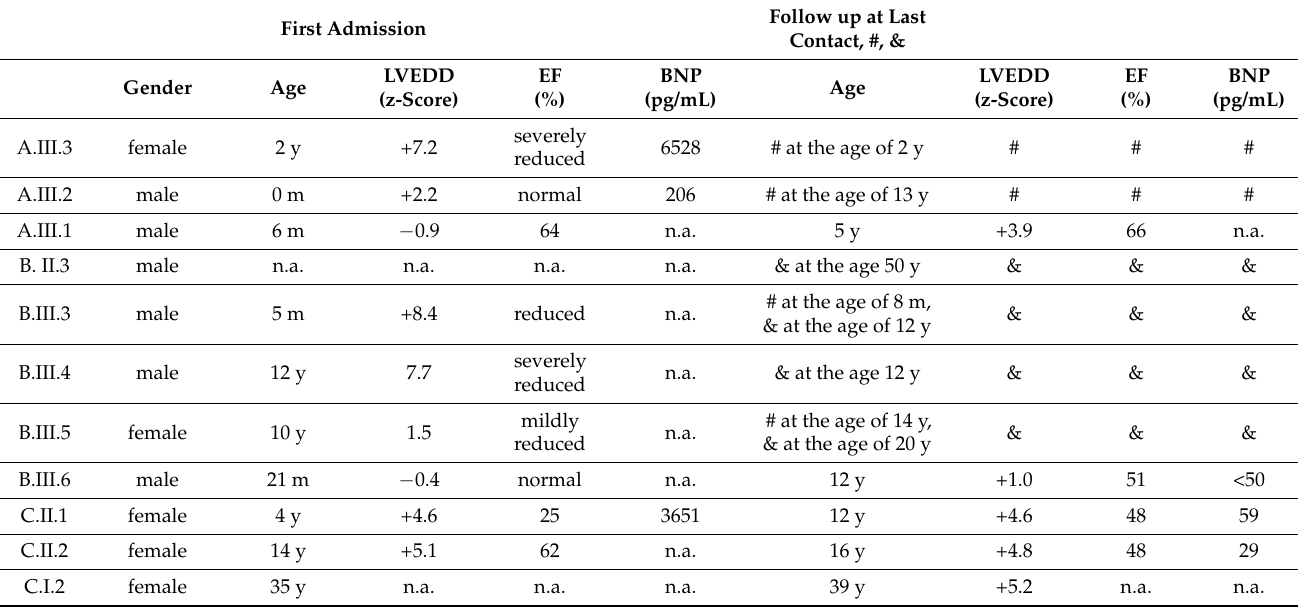
Table 1. Patient